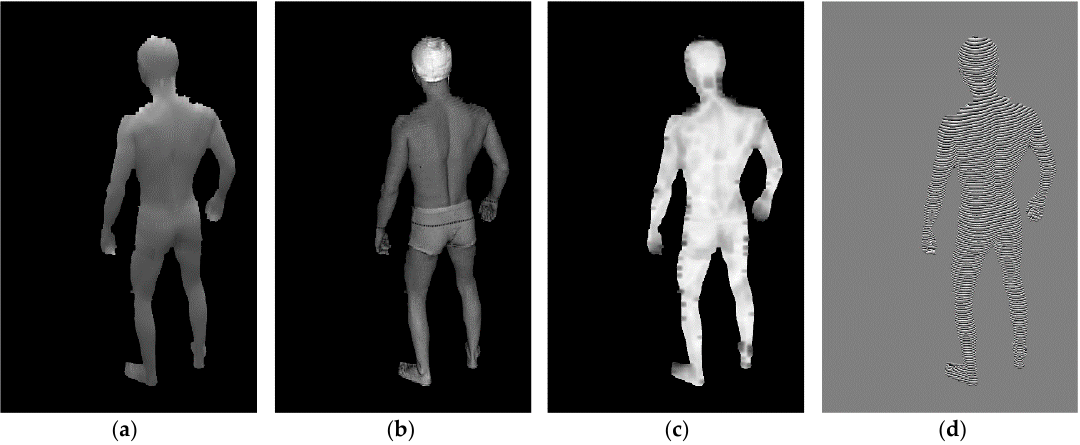
Figure 7. Example images depicting certain maps calculated in this study: ( a ) Pm; ( b ) Am; ( c ) Sm; ( d ) Wm.